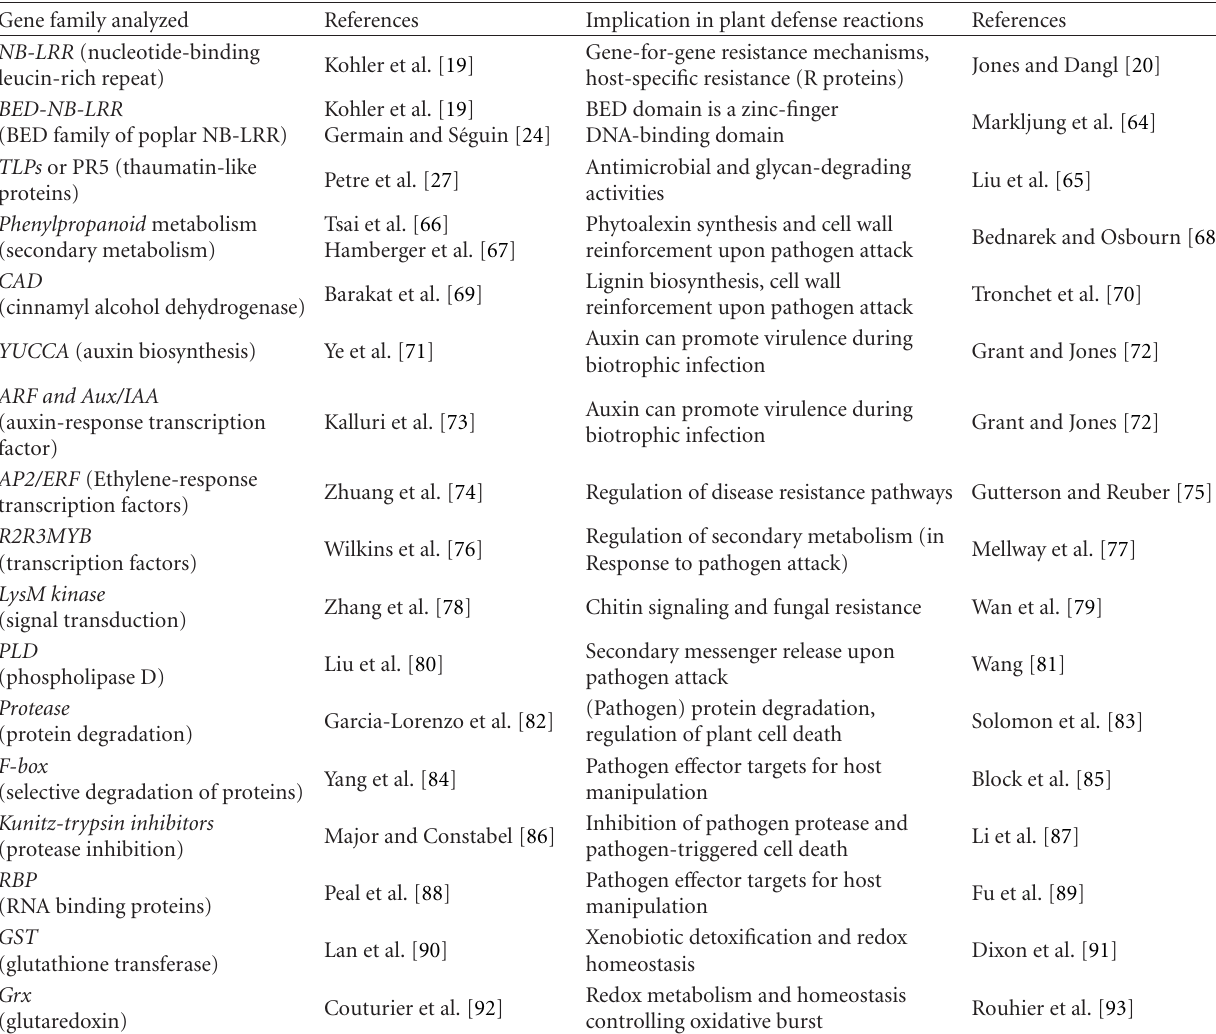
Table 1: Summary of genome-wide studies conducted on disease-related gene families in